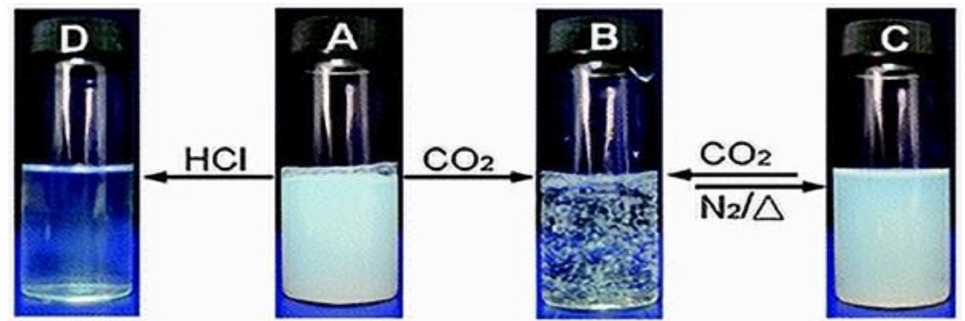
Figure 10. 2.0 wt% ODPTA aqueous dispersion: ( A ) the initial dispersion; ( B ) bubbling CO 2 (0.1 MPa); ( C ) switching CO 2 with N 2 (0.1 MPa) at 75 ◦ C; and ( D ) altering the pH with HCl as in ( B ) “Reproduced with permission from Ref. [112]; 2022, Royal Society of